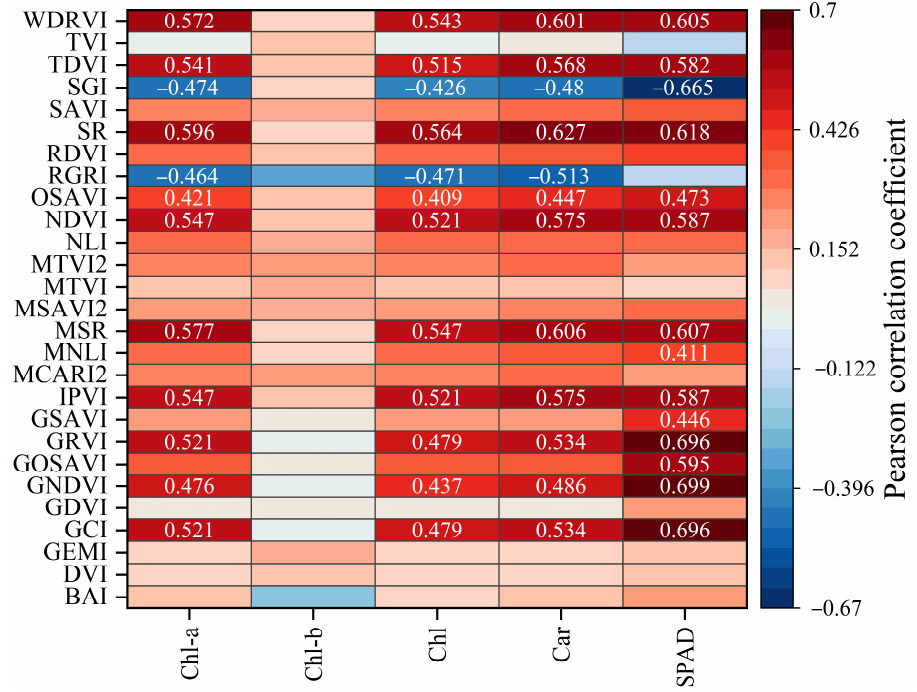
Figure 9. Heat map of correlation between the measured PPCs and the mean values of 27 spectral indices corresponding to the 30 sample trees.